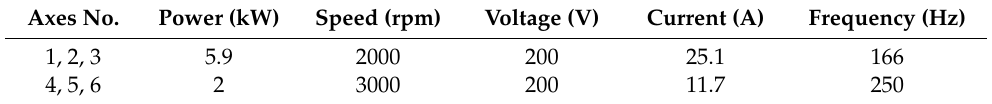
Table 1. Specifications of the electric motors.